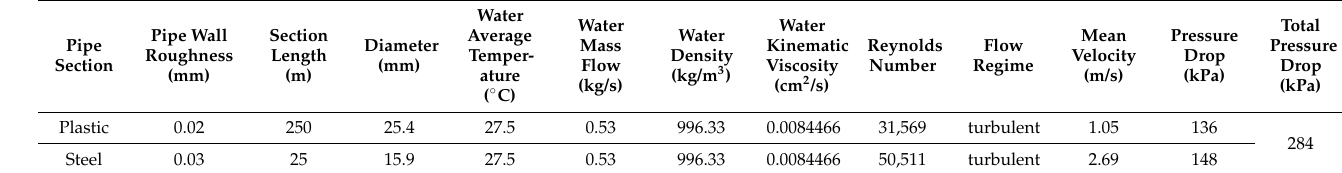
Table 3. Pressure drop of the ground loop recirculating